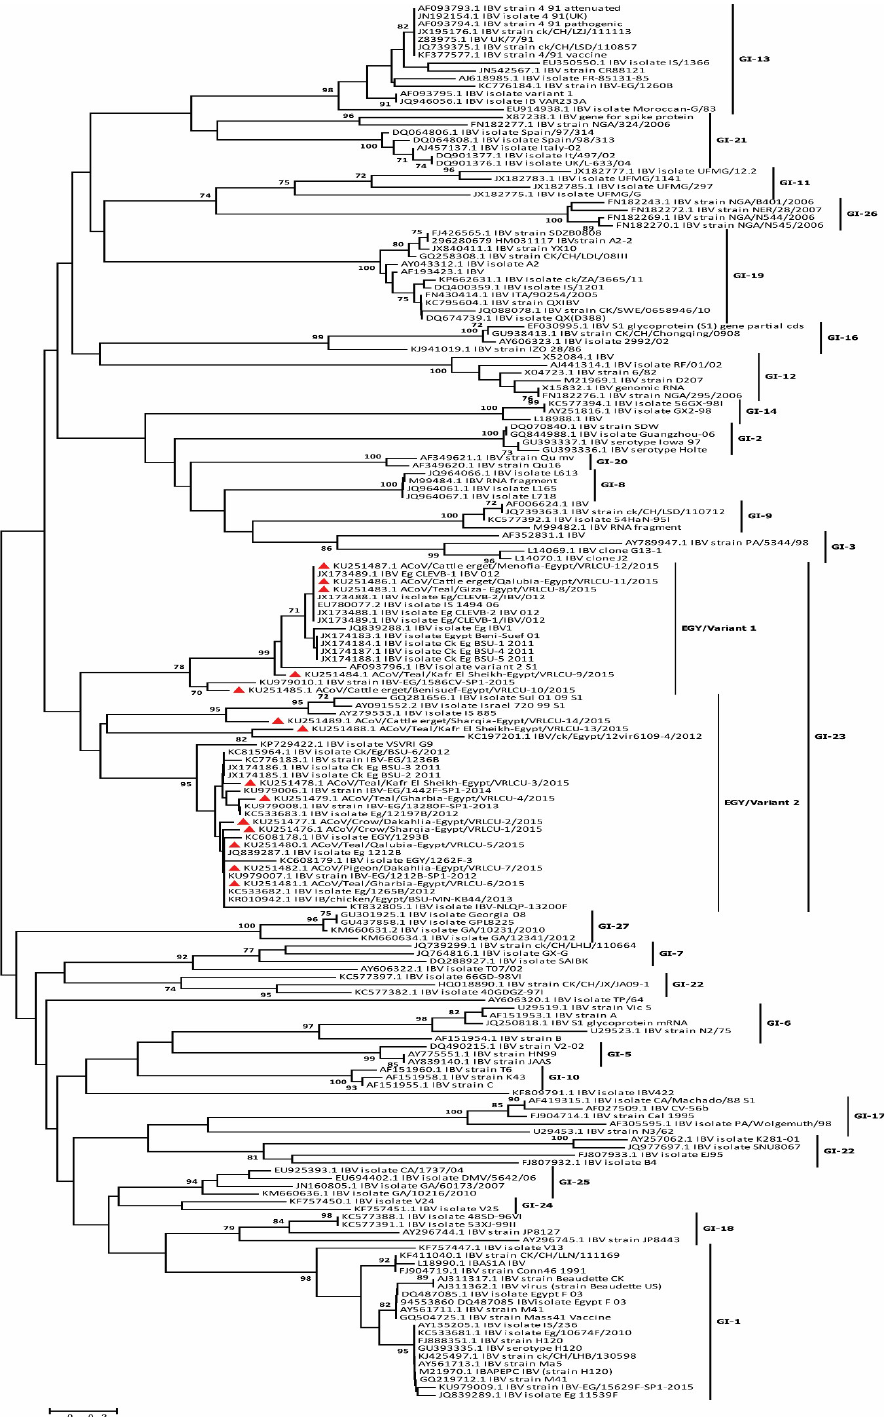
Figure 4. Phylogenetic tree based on a full-length sequence of the S1 gene, showing the relationship between the circulating Egyptian genotypes in commercial poultry sectors in relation to ACoV isolates reported in this study. The robustness of individual nodes of the tree was assessed using 1000 replications of bootstrap re-sampling of the originally aligned nucleotide sequences. Scale bar represents the number of substitutions per site. The year of isolation and geographical origin of the virus sequences are included in the tree. Tree was constructed using maximum likelihood method. The reported isolates in this study are marked with red